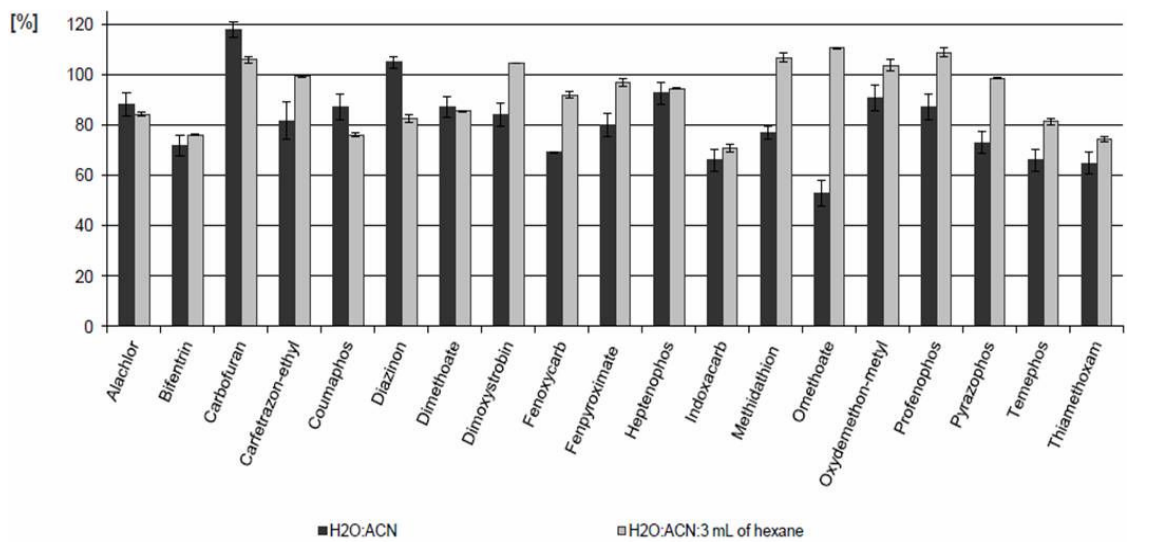
Figure 1. Recovery changes during the optimization of the extraction